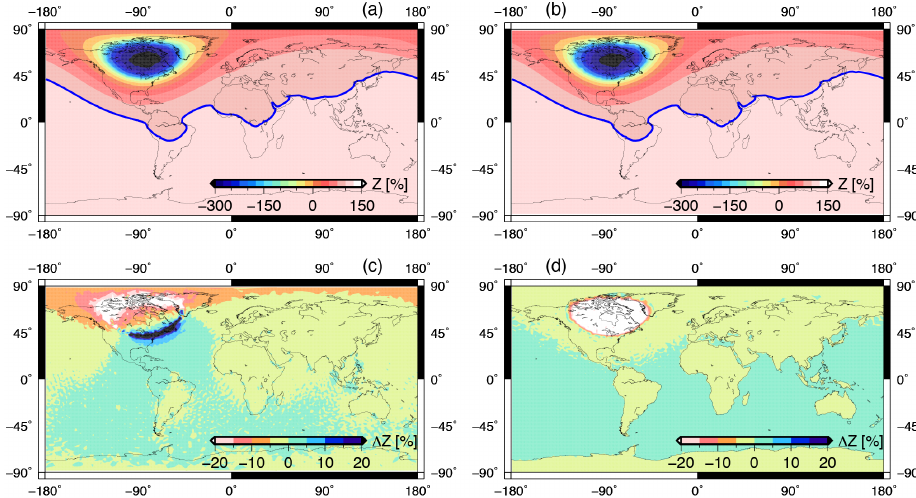
Figure B2. Change in relative sea level induced by deglaciation on an elastic non-rotating earth. Normalized sea level with respect to global mean value (see Eq. B1), computed by (a) our mesh model and (b) a pseudo-spectral model for similar computational settings. Z = 100% contours are plotted (in blue) to facilitate comparison. (c) Difference between the two model solutions. Some (random) discrepancies appear- ing particularly around the deglaciated region may be considered as numerical artifacts due to differing model algorithms. (d) Difference between two mesh models with L = 128 and L = 10000 (Eq. 14). Large discrepancies appear around the deglaciated region, implying the systematic errors associated with low-degree SH representation of solid-earth response.